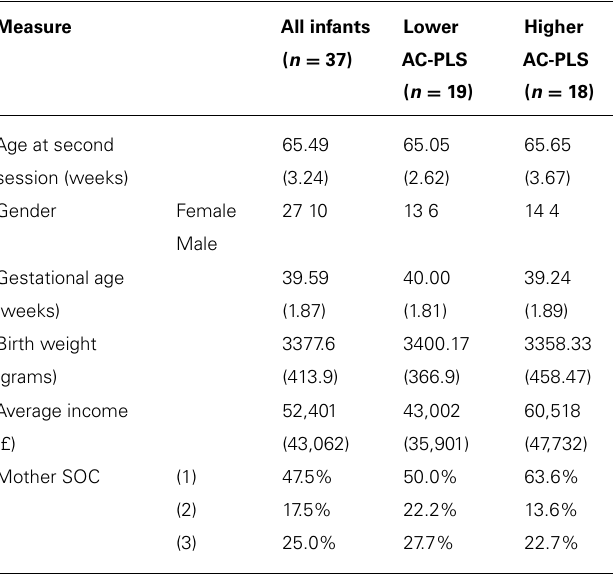
Table 1 | Demographic characteristics of the higherAC-PLS and lower AC-PLS groups of infants (standard